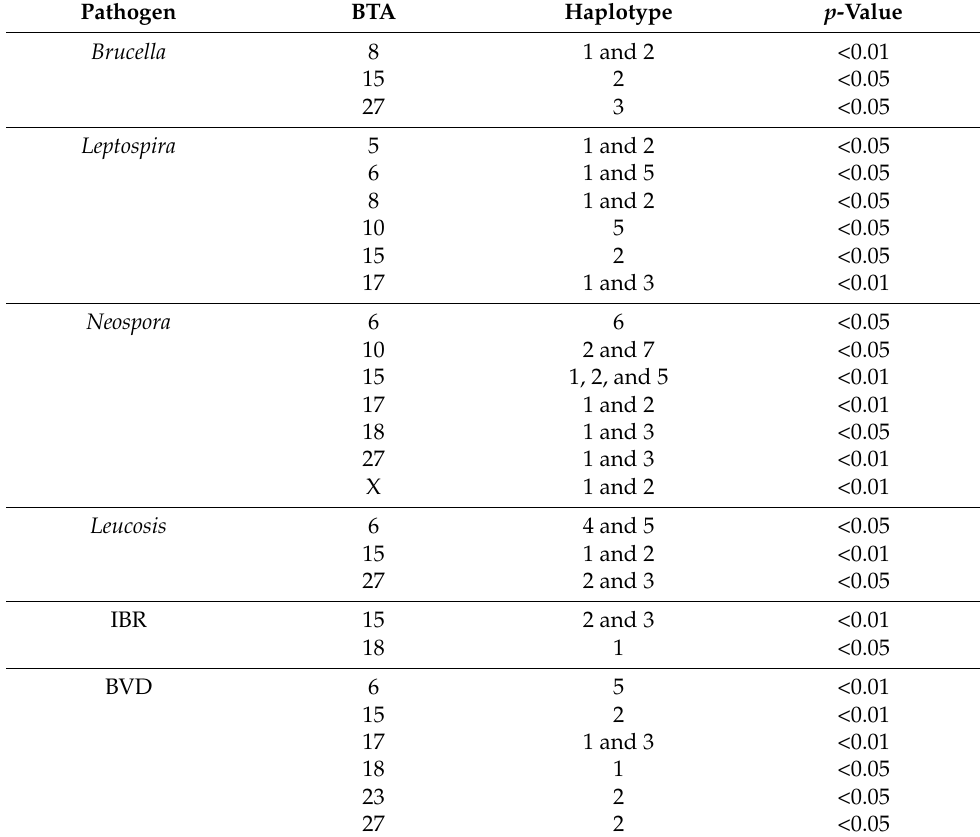
Table 5. Significant Chi-square test results of SNP haplotypes and infections in Curraleiro P é -Duro cattle.